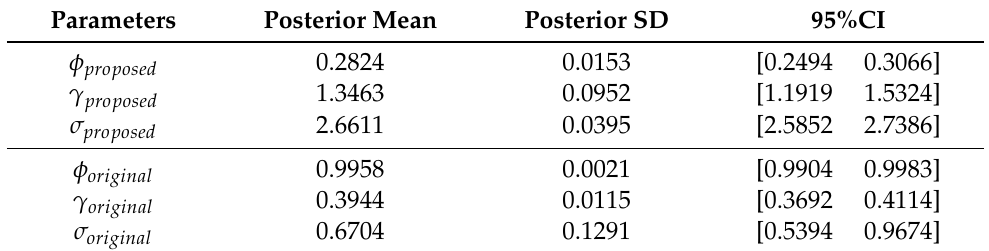
Table 37. Comparison of estimated parameters (27 July 2016, AGH, Tokyo, Japan).